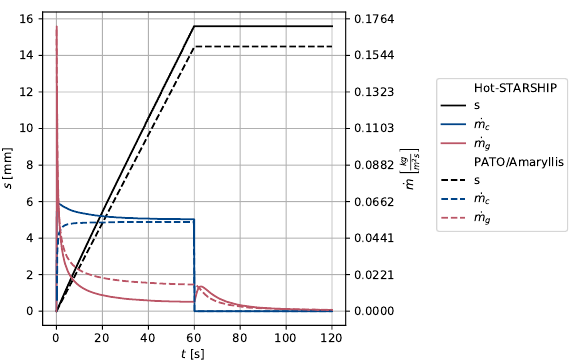
Figure A1. Comparison of Hot-STARSHIP and Amaryllis/PATO recession and mass flow rates. Hot-STARSHIP analysis results in a 7.6% higher final recession value s (15.6 mm versus 14.5 mm). This difference can be attributed to the initial difference in char mass